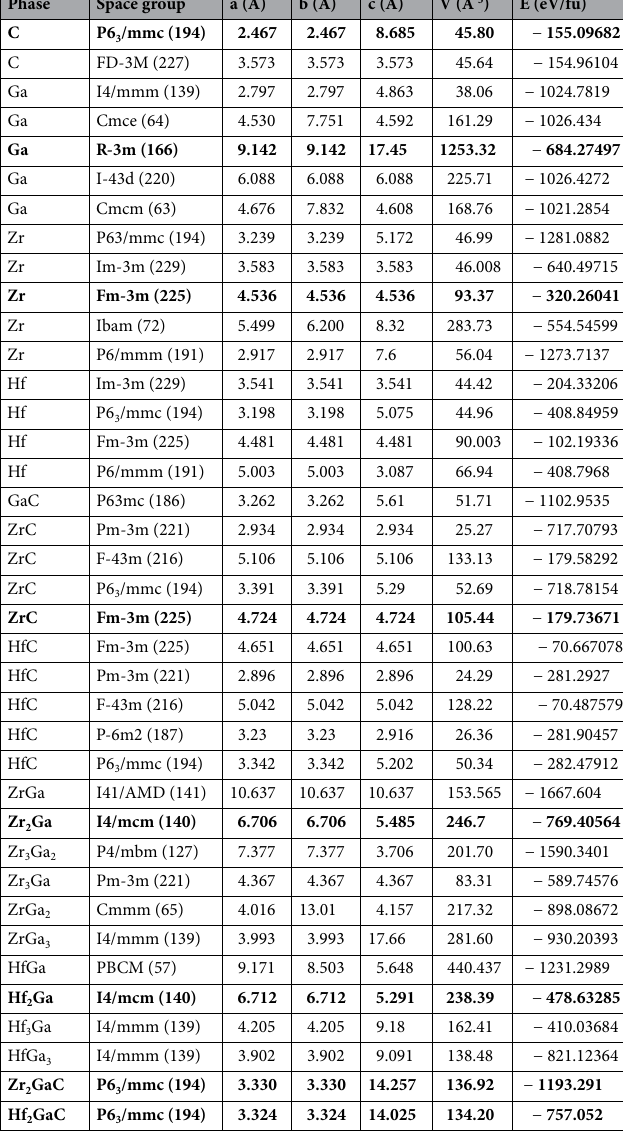
Table 2. Lattice parameter, unit cell volume, and total energies of M 2 GaC and its competing phases considered. The phases in bold are the non-MAX competing phases obtained from the linear optimization to calculate the formation enthalpy of the M 2 GaC MAX